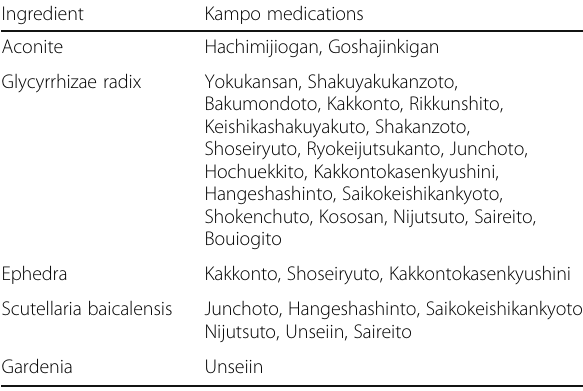
Table 1 Kampo medications containing aconite, Glycyrrhizae radix, ephedra, Scutellaria baicalensis or gardenia that were prescribed for 80 ambulatory elderly